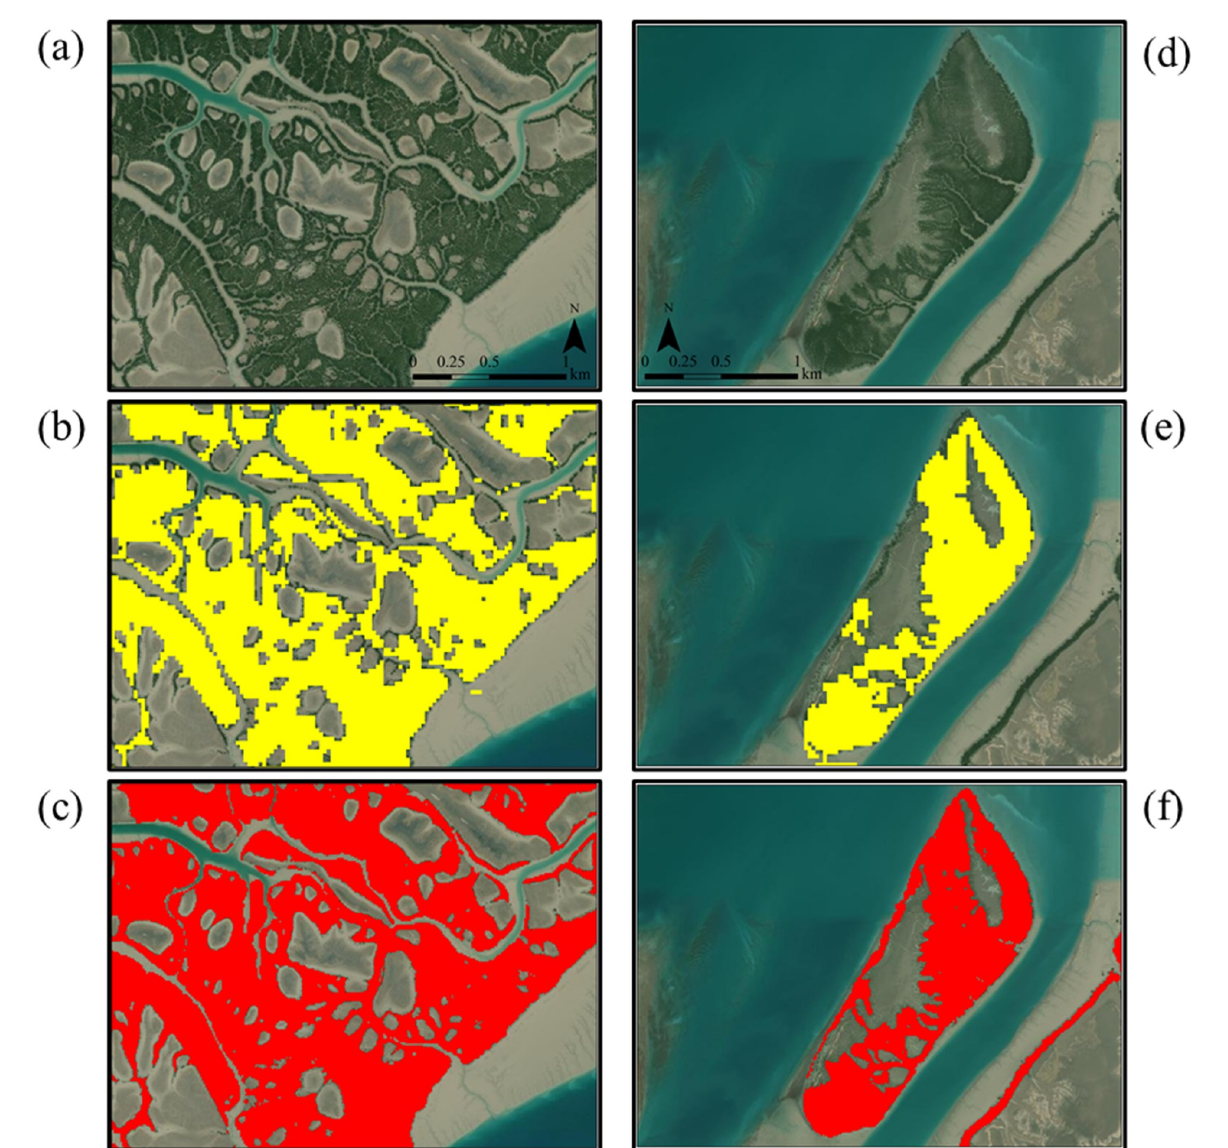
Figure 7. High-resolution satellite images of two mangrove areas ( a , d ), mangrove extents from the recent global mangrove map ( b , e ) [74], and mangrove extents derived from the proposed method ( c , f ).